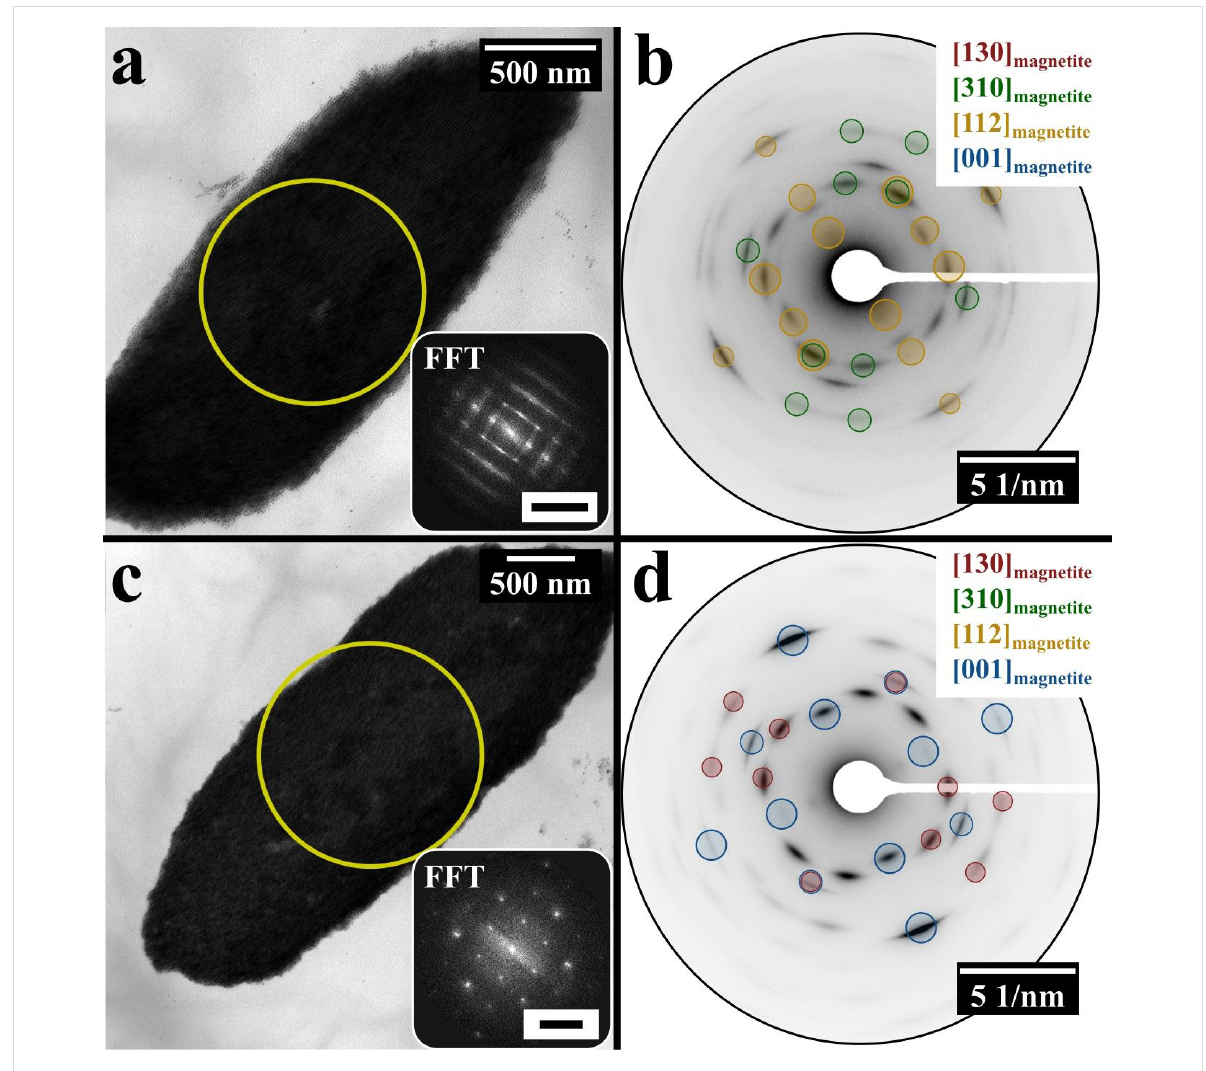
Figure 3: TEM images of two directed mesocrystals and their corresponding ED and FFT patterns. The large yellow circles indicate the positions where the EDs and FFTs were taken. The zone axes contributing to the ED patterns are noted and some diffraction reflections are highlighted and colour coded. (a) A directed mesocrystal with a projected p 4 mm layer symmetry (inset: 200 1/µm). (b) The ED pattern of the directed mesocrystal shown in (a). The texture-like diffraction pattern proves the mesocrystalline character of the directed assembly. (c) A directed mesocrystal with a projected c 2 mm layer symmetry (inset: 100 1/µm). (d) The ED pattern of the directed mesocrystal shown in (c). The texture-like diffraction pattern slightly differs from the pattern in